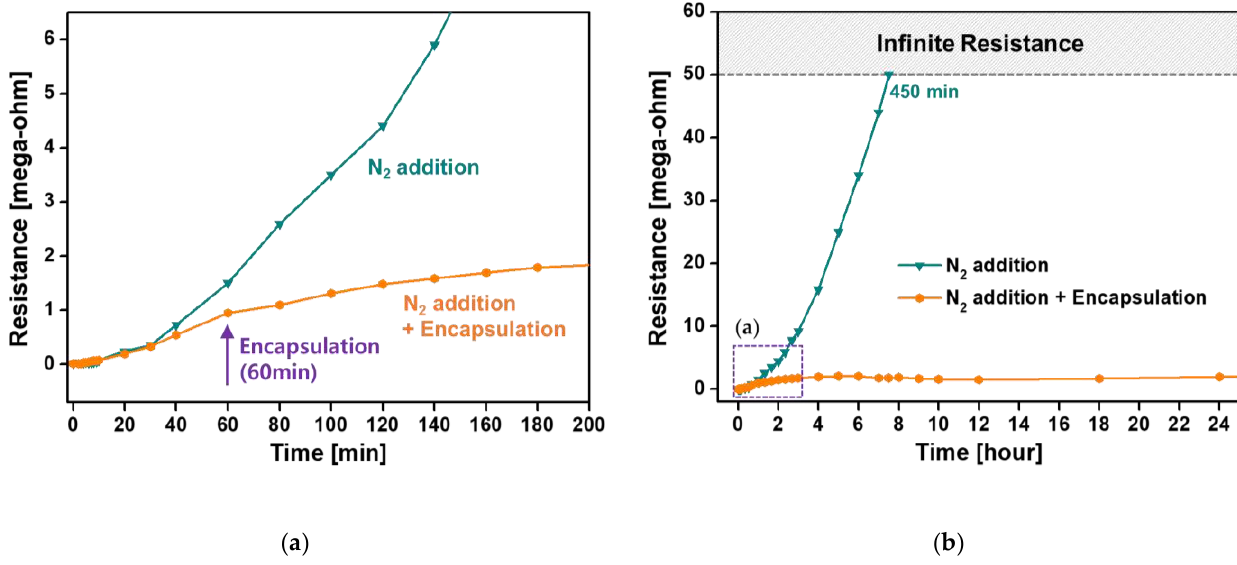
Figure 9. Comparison of the electrical resistance of ex situ I 2 -doped PANI films with and without encapsulation: ( a ) resistance changes in initial 3 h and ( b ) resistance changes in 24 h. Encapsulation test proceeds with PANI films polymerized with N 2 gas addition.